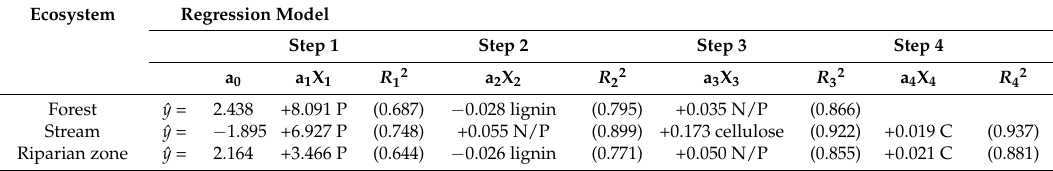
Table 4. Regression model of the stepwise regression analysis between cellulose degradation rate (%/month) during two years and foliar litter initial chemical